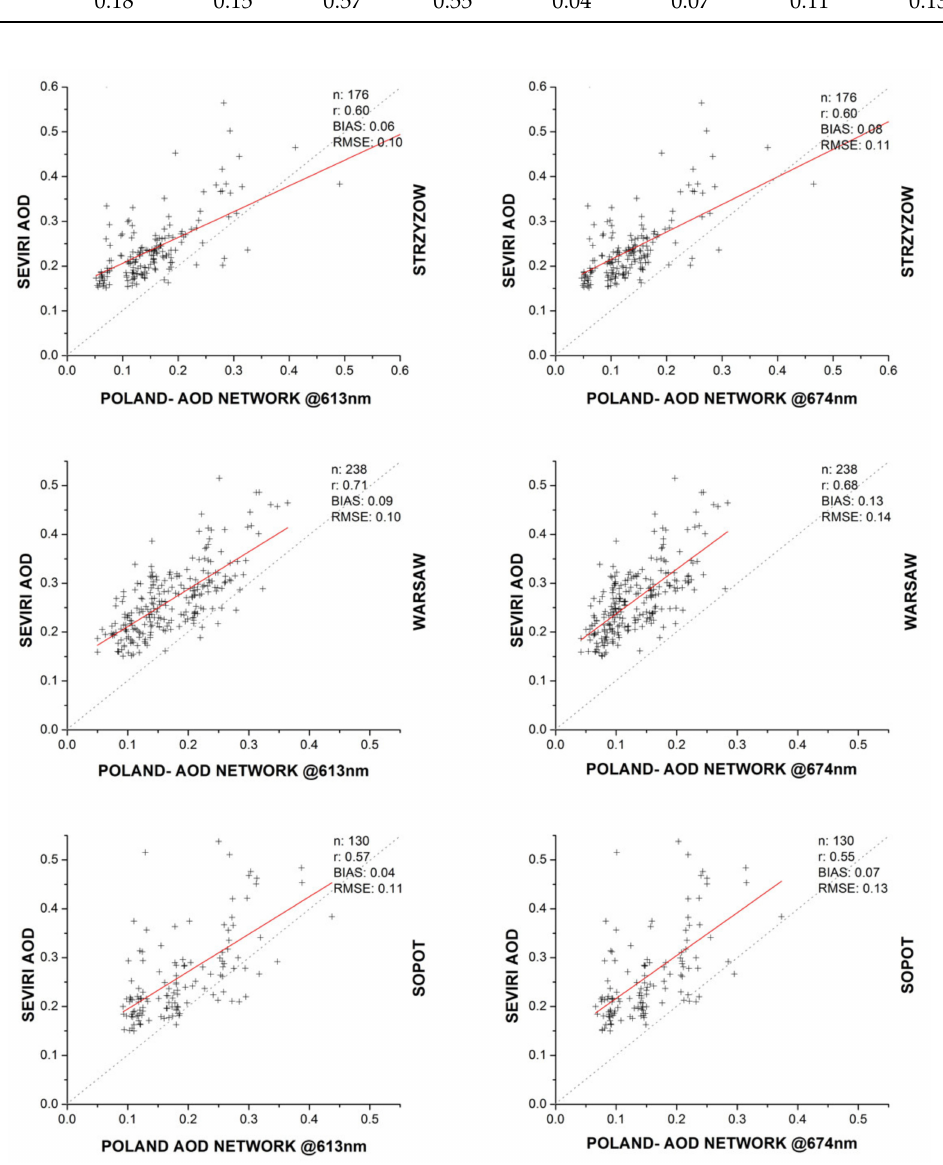
Figure 3. Correlation plots of the AOD measured in the Poland–AOD network sites in Warsaw Sopot and Strzyzow at 613 nm ( left ) and 674 nm ( right ) versus the SEVIRI AOD pixel (635 nm) derived for these locations during the period of June–September 2014. The red line shows linear